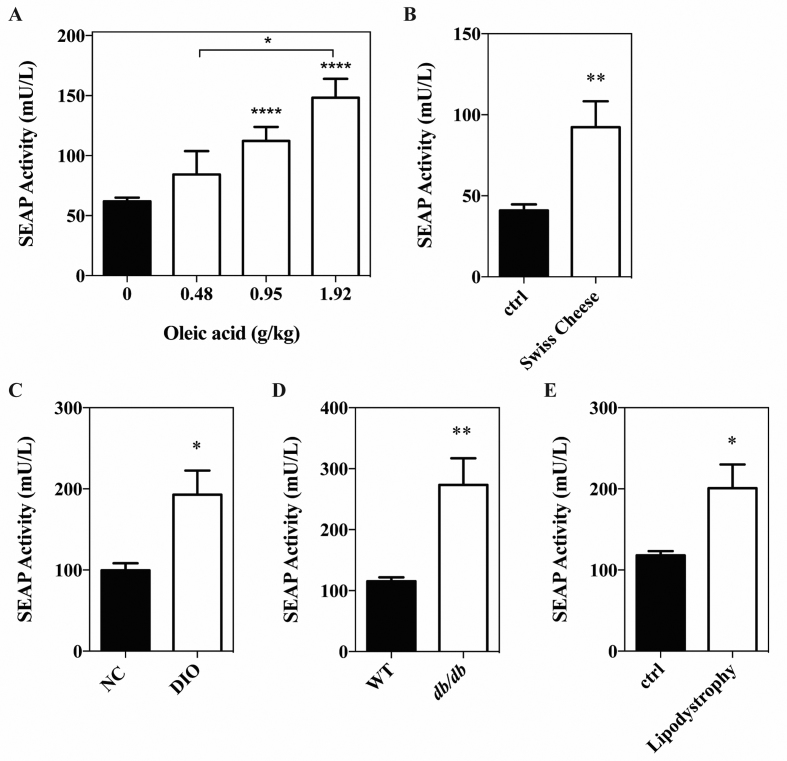
FATS-controlled transgene expression in mice. Mice implanted intraperitoneally with microencapsulated pYL4/pYL1-transgenic HEK-293T cells received (A) oleic acid (0 or 1.92 g/kg, n = 14; 0.48 or 0.95 g/kg, n = 7) or (B) Swiss cheese (10.7 g/kg, n = 7) by oral gavage twice daily, and blood SEAP activity was assayed after 24 h. (C) Mice were fed on HF diet (60 kcal% fat) (DIO) or normal chow (4 kcal% fat) (NC) for 15 weeks before receiving cell implants, and SEAP levels in the serum were assayed after 24 h (n = 7). (D) SEAP levels in diabetic db/db mice and their wild-type counterparts (WT) at 24 h after receiving cell implants (n = 7). (E) After receiving oral ritonavir (50 mg/kg⋅d) for 20 days, mice were injected with microencapsulated HEKpYL4/pYL1 cells and blood SEAP was assayed after 24 h (n = 7). Data are means ± SEM; statistics by two-tailed t test; ∗P < 0.05, ∗∗P < 0.01, ∗∗∗∗P < 0.0001 versus control or as indicated.